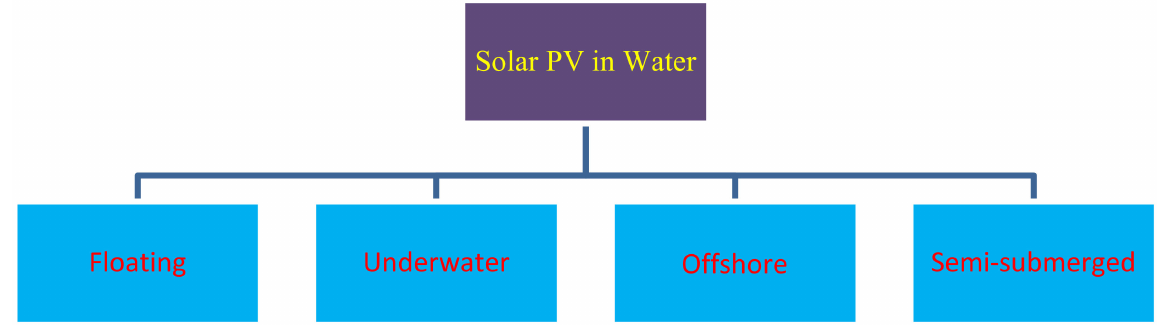
Figure 2. Classification of PV in water